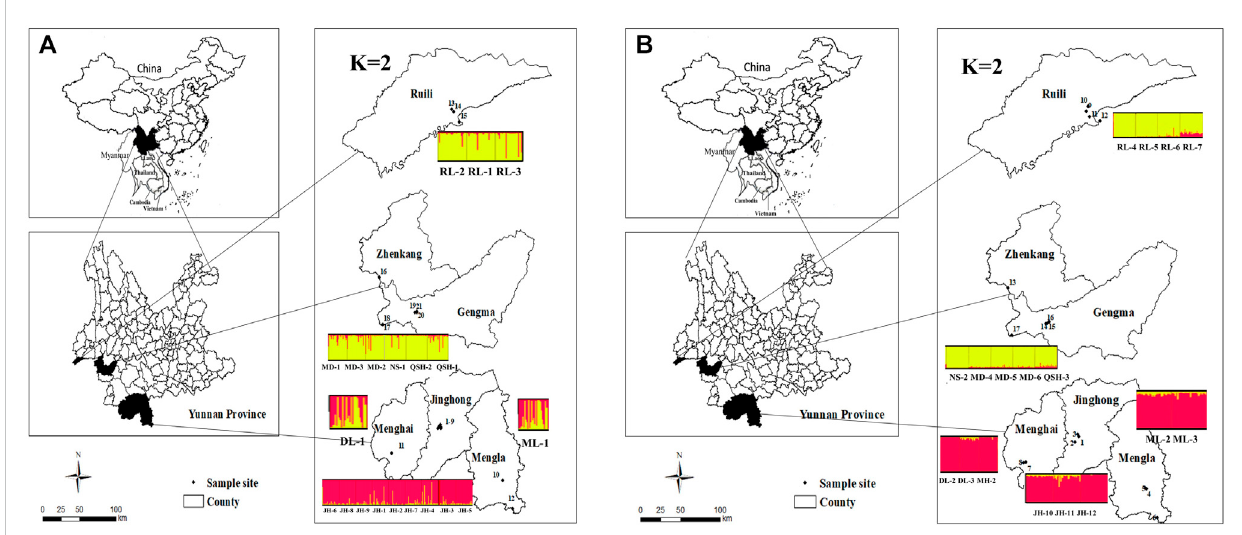
FIGURE 1 Distribution map of sampling locations and a plot of K = 2 cluster in Yunnan Province. Structure bar plot for all Ae. aegypti populations used in this study.Theheightofeachcolorrepresentstheprobabilityofassignmenttoaspeci fi cclusterFigure1 (A) :Distributionmapofsamplinglocationsandaplot of K = 2 cluster in Yunnan Province, 2019. Figure 1 (B) : Distribution map of sampling locations and a plot of K = 2 cluster in Yunnan Province, 2020.